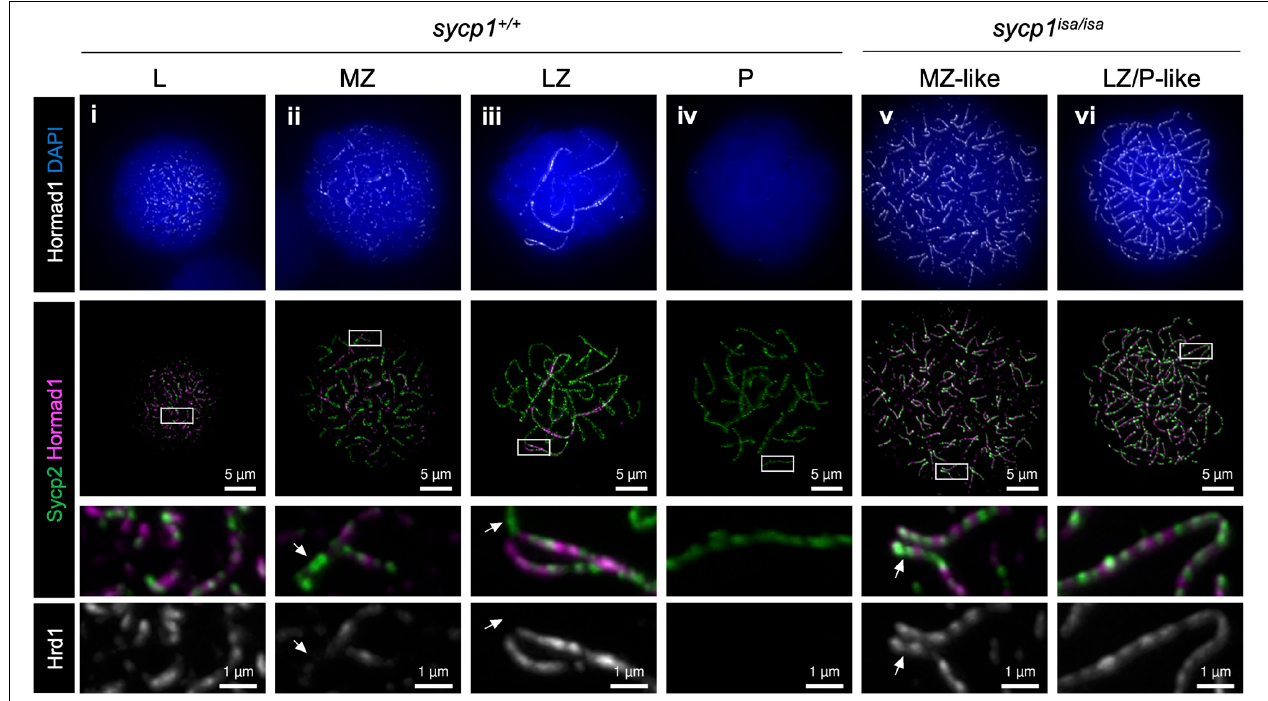
FIGURE 7 | Hormad1 localization in sycp1 mutant spermatocytes. Costaining of Hormad1 and Sycp2 in sycp1 + / + (i to iv) and sycp1 isa / isa (v and vi) spermatocytes. Regions marked as a white rectangle are shown at a higher magnification at the bottom. Arrows indicate synapsed ( sycp1 + / + ) and paired ( sycp1 isa / isa ) regions of